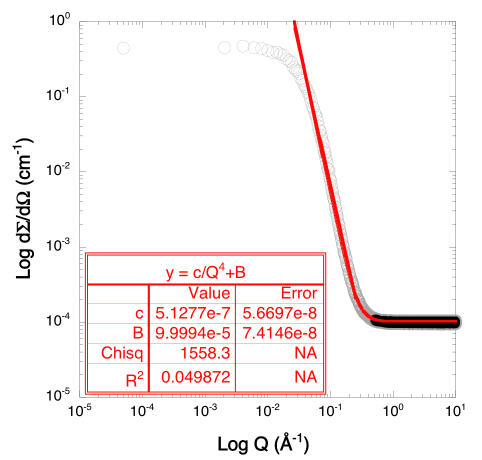
Figure 7. Porod approximation of the simulated SCS by using the SDF with σ = 0.4 and an incoherent background of 1.0 × 10 − 4 cm − 1 . The points used are shown with black symbols, while the others are red. The fit is shown with a red